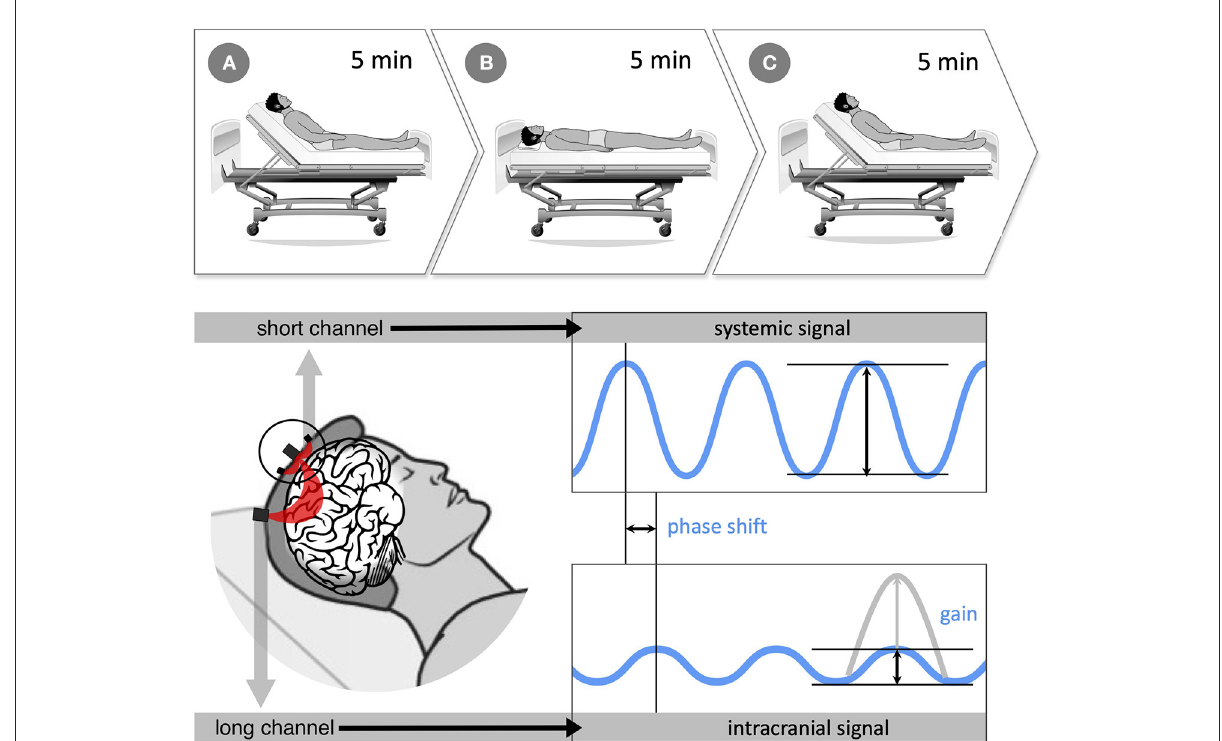
FIGURE3 (Top) experimental protocol with 3-, 5-min recording periods (sections A 30 ◦ , B 0 ◦ , and C 30 ◦ ). First, the baseline was recorded for 5min with the upper body upright at 30 ◦ (section A), then the upper body was passively lowered to 0 ◦ in the horizontal position (section B). Finally, after another 5min, the upper body was passively raised to 30 ◦ (section C). The entire recording lasted 15min. (Bottom) data acquisition and processing: near-infrared spectroscopy (NIRS) measures hemodynamic changes with optodes transmitting near-infrared light through the head surface into the brain tissue. Long-distance channels have ∼ 3.0cm between the light source and its detector and provide information on intracerebral hemodynamics. Short-distance channels are located directly next to each light source (0.8cm) and record systemic blood pressure (BP) changes in the scalp. Systemic and intracranial signals were set in relation using discrete fourier transform to obtain information on cerebral autoregulation (CA). Like that, systemic and intracranial BP curves can be compared in amplitude ( gain ) and shift in time ( phase shift ). The